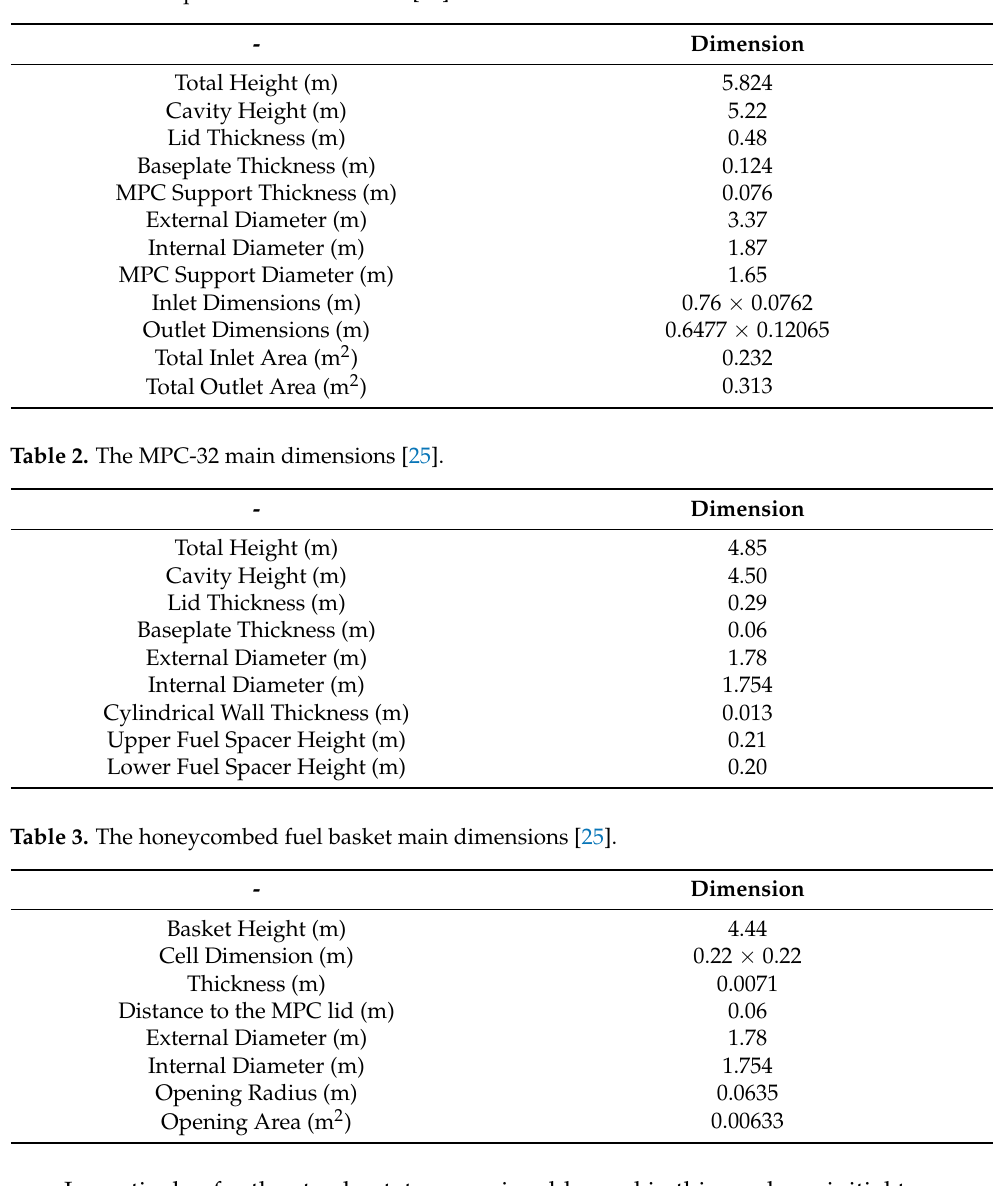
Table 1. The overpack main dimensions [25].